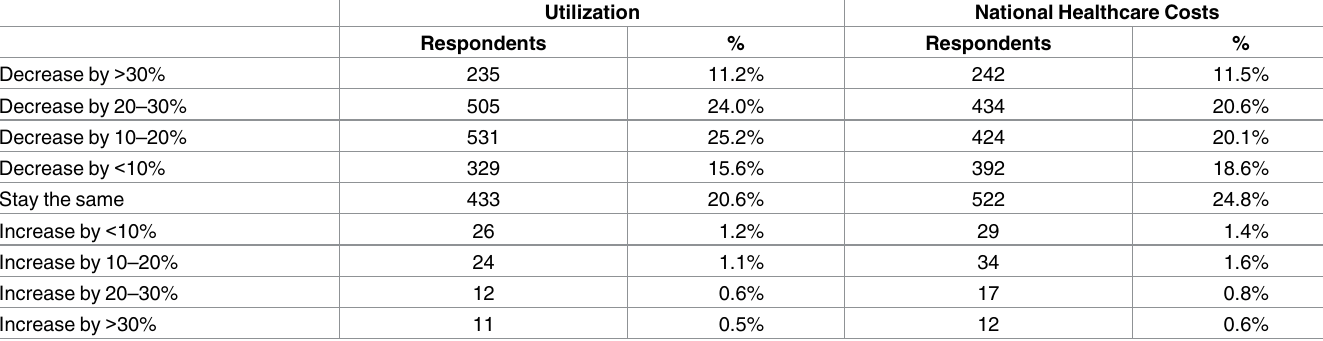
Table 5. Physician perceptions on potential impact of reducing fee-for-service physician reimbursement (N =